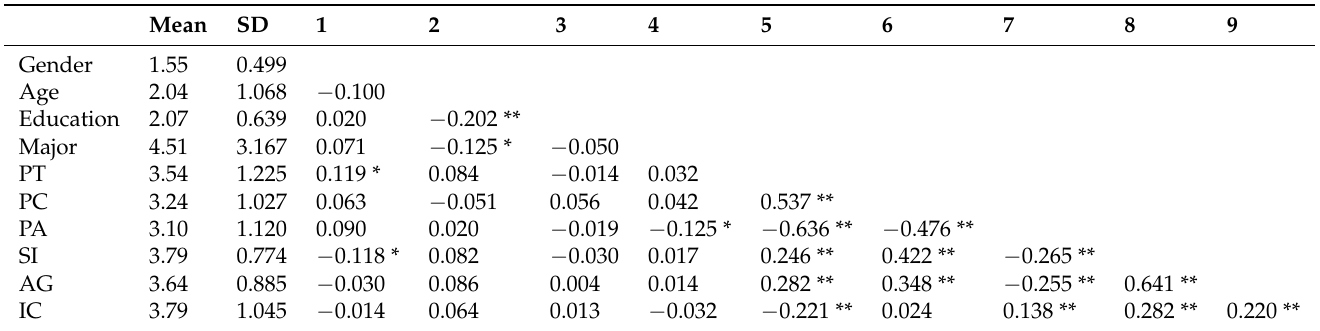
Table 1. Means, Standard Deviations, and Correlations (N =